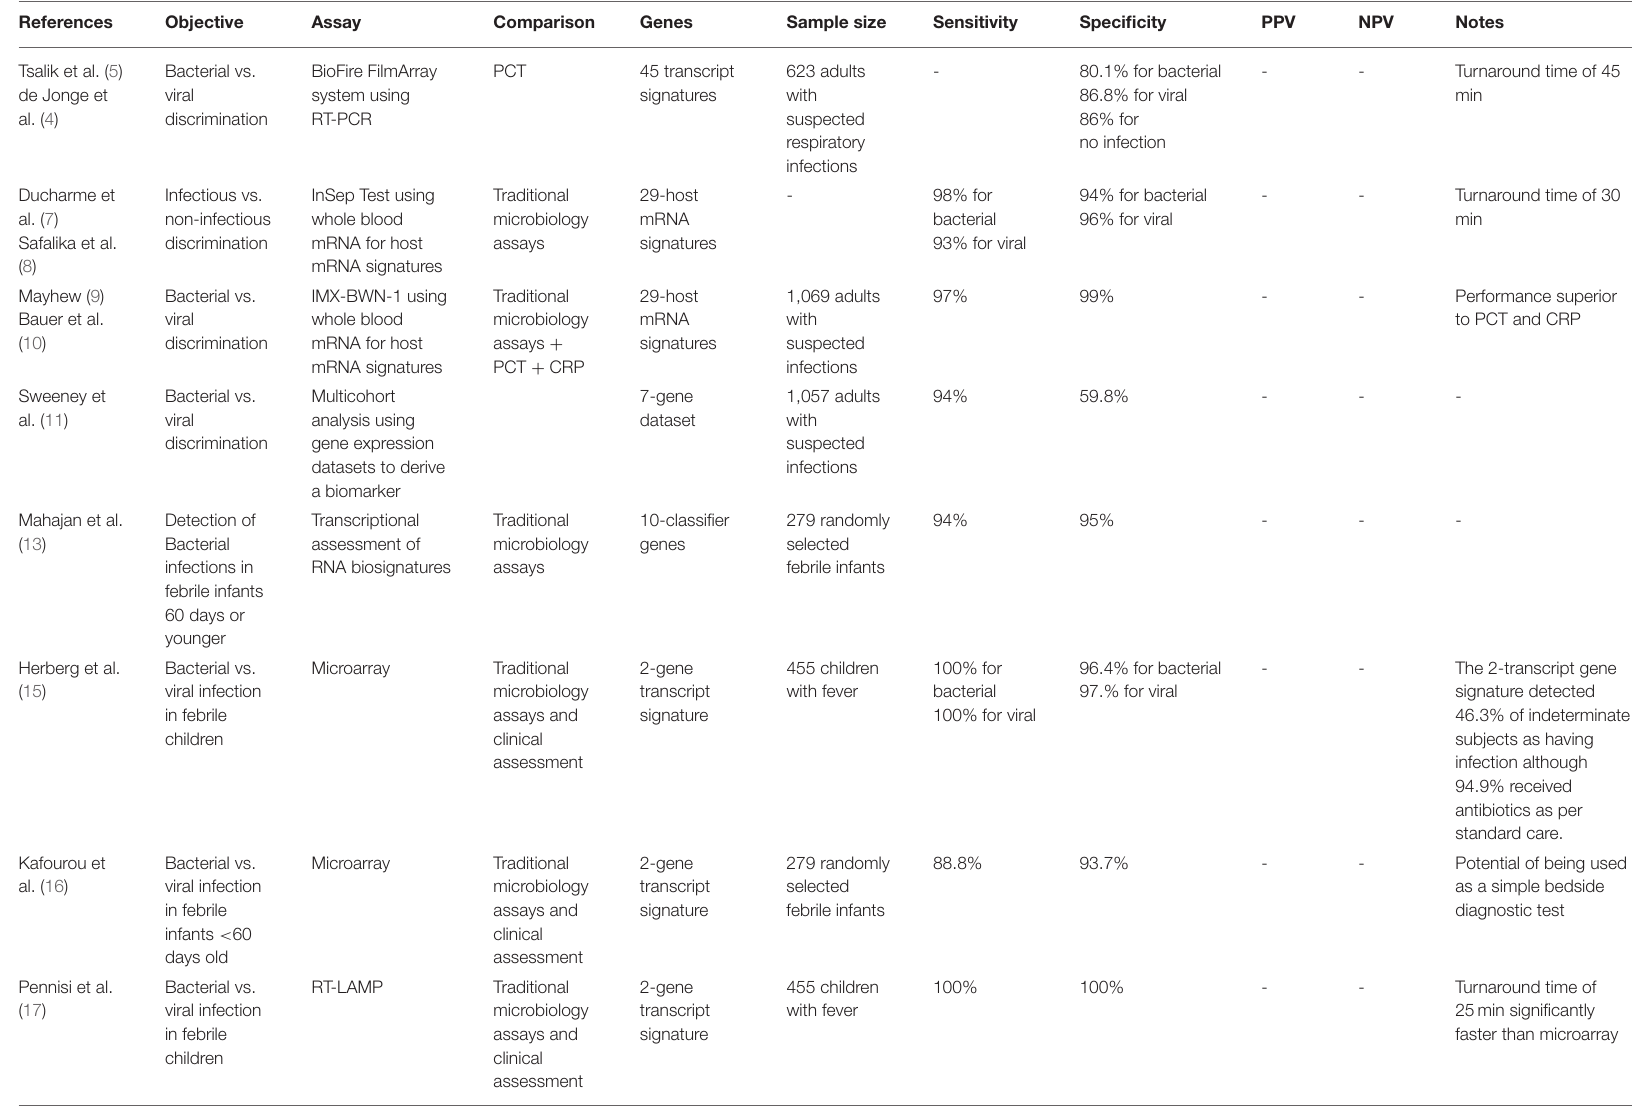
TABLE 1 | Use of host-response diagnostics for discrimination of bacterial vs. viral